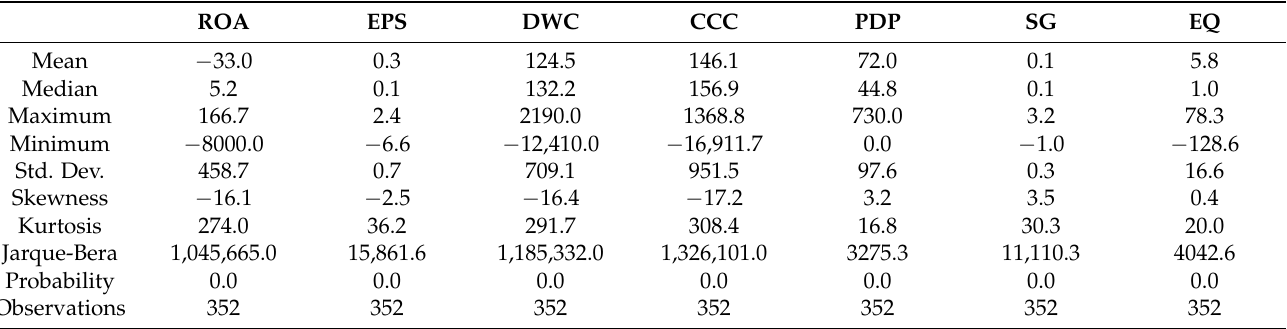
Table 2. Descriptive statistics for the